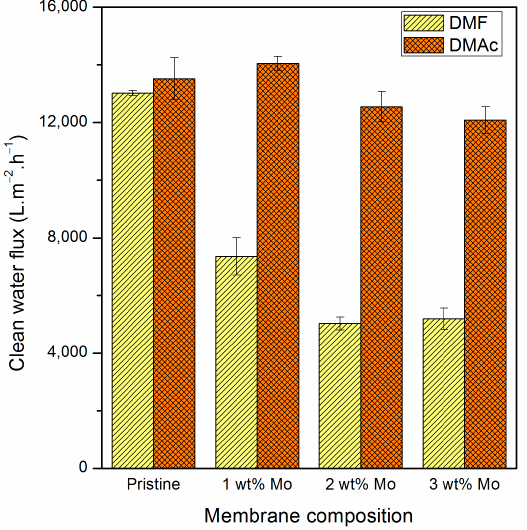
Figure 8. Clean water flux as measured for each membrane.